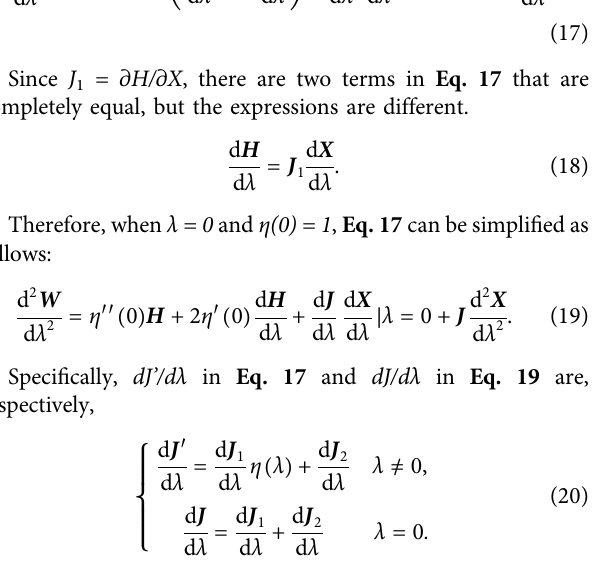
TABLE 2 | Calculation result of the voltage under breaking branches 3 – 4 in the IEEE14 node system. Node N – R accurate value